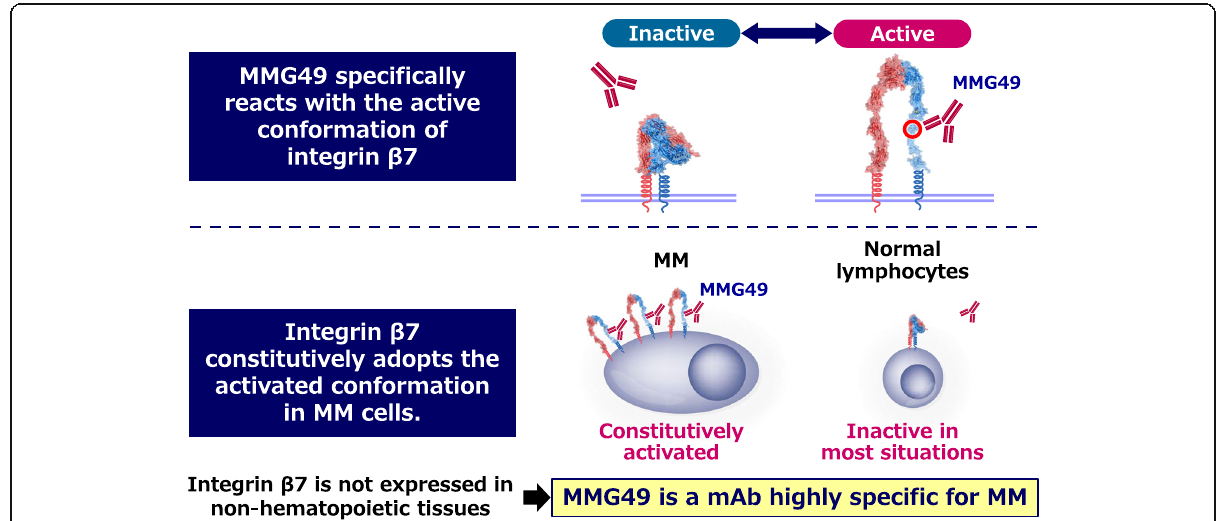
Fig. 1 MMG49 specifically reacts with the activated conformation of integrin β 7 expressed on MM